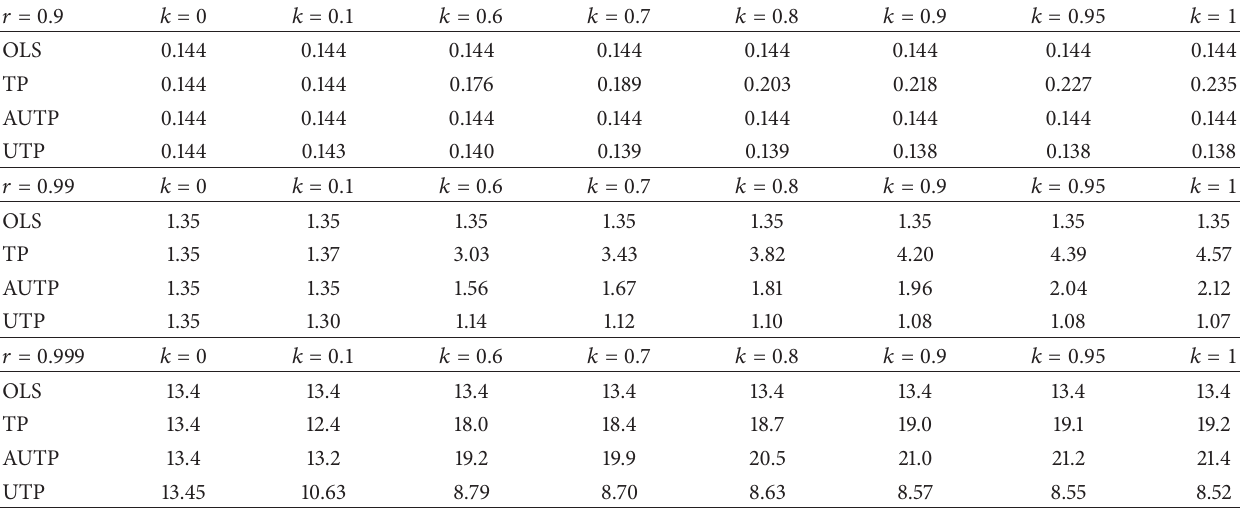
Table 8: Estimated MSE values of OLS, TP, AUTP, and UTP when 𝑛 = 50 , 𝑝 = 6 , and 𝜎 2 = 0.25